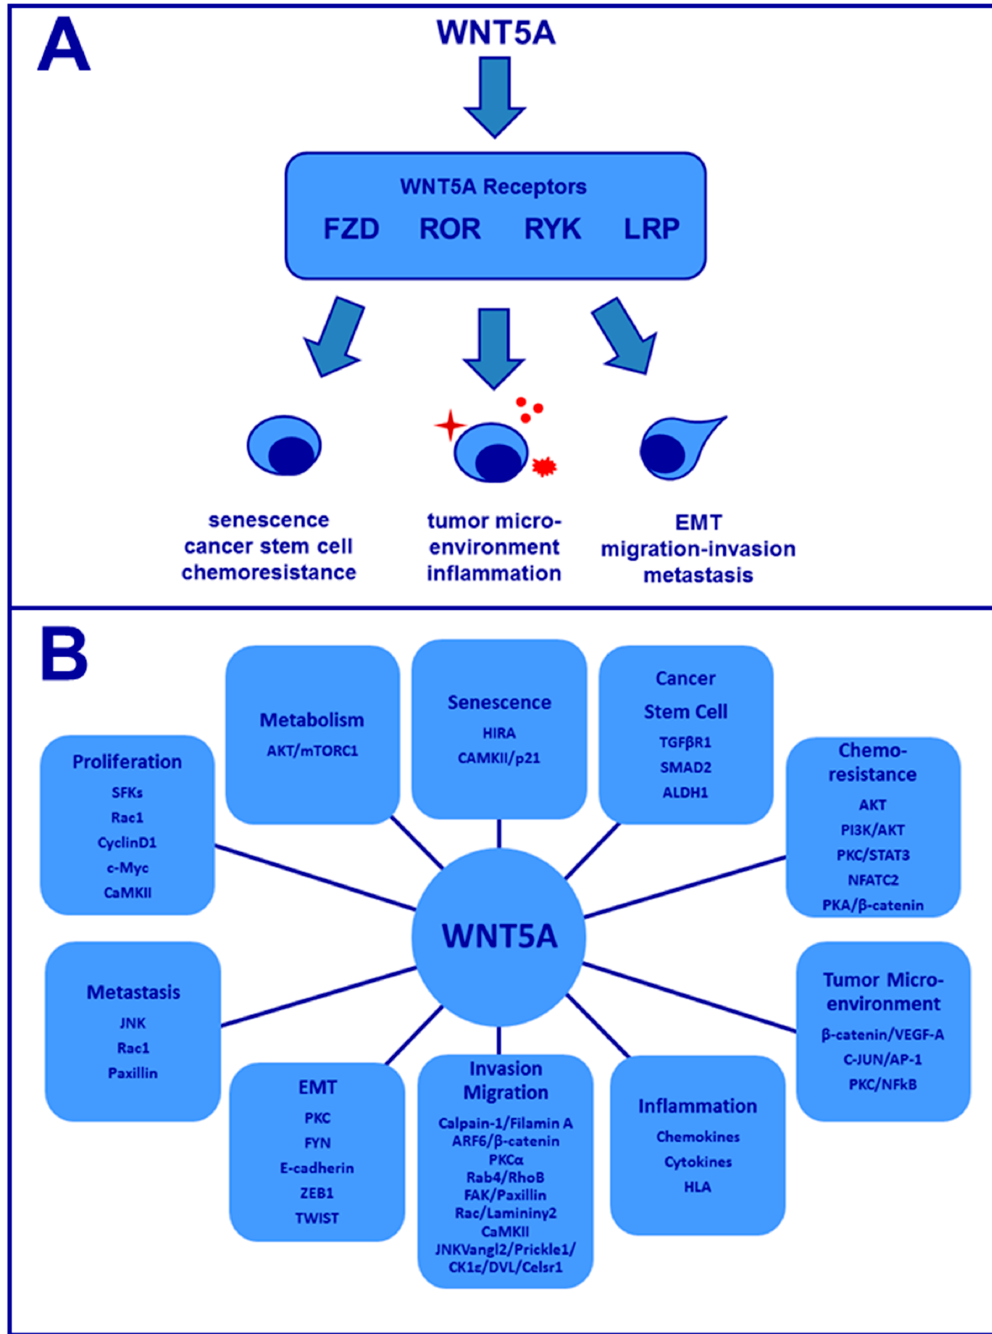
Figure 1. Overview of Wnt5a signaling in cancer. ( A ) Wnt5a binds to a number of distinct trans‐membrane receptors to influence a diverse array of tumor cell behaviors; ( B ) Summary of Wnt5a effector proteins that influence cell behavior.